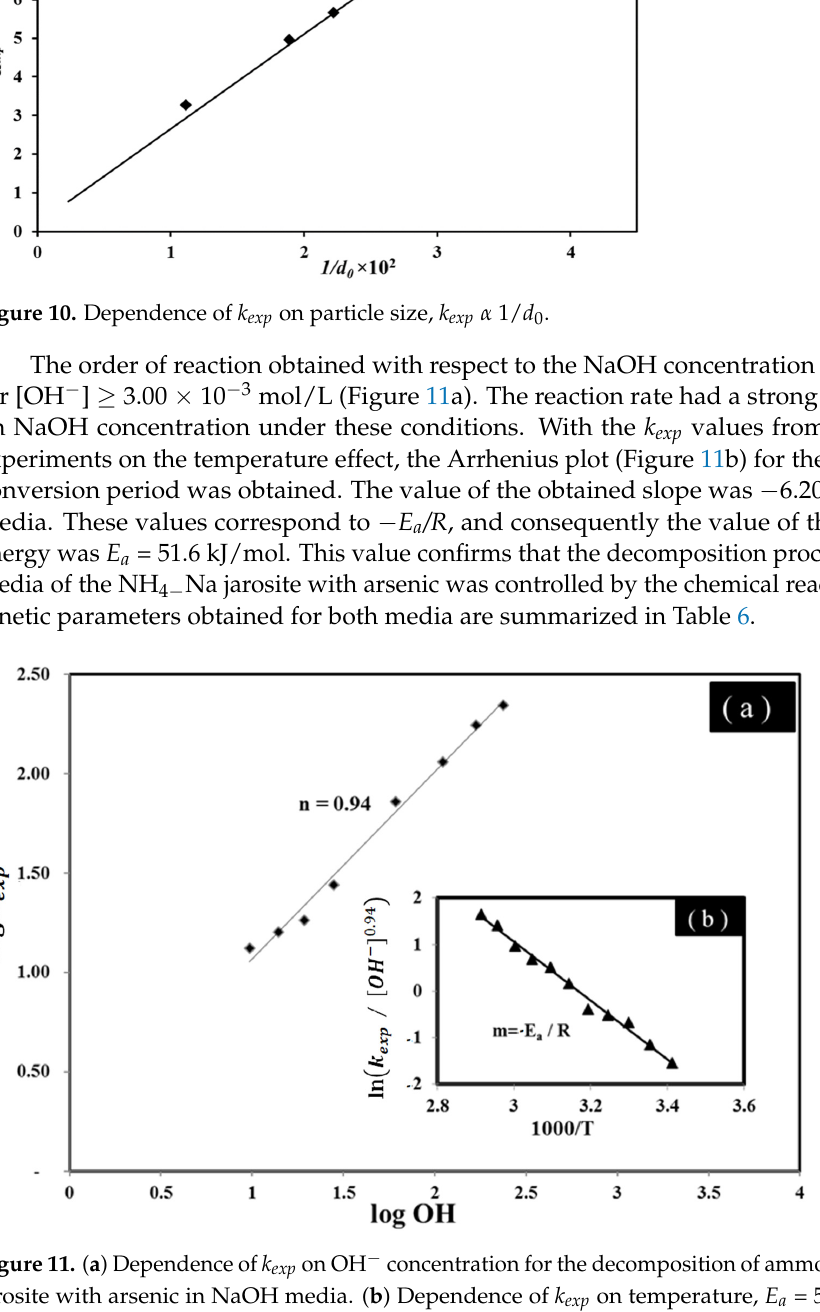
Kinetic Parameter